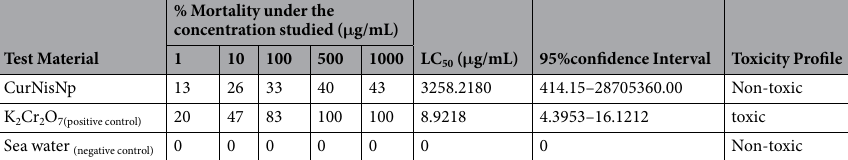
Table 4. Percentage mortality of brine shrimp at different doses of